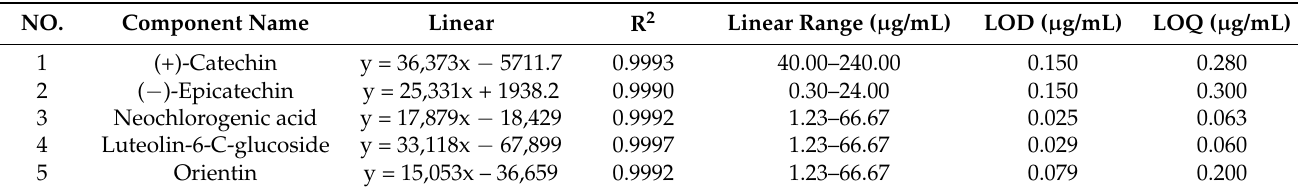
(Table 6). Qualitative and quantitative analyses of target chemical composition in the hairy roots and true roots were performed (Supplementary Materials Figure S4). The (+)-catechin and ( − )-epicatechin contents in the hairy roots were 692.63 ± 127.24 and 163.34 ± 31.86 µ g/g DW, respectively, whereas those in the true roots were 622.52 ± 97.53 and 70.21 ± 25.12 µ g/g DW, respectively (Table 6). The neochlorogenic acid, luteolin-6-C-glucoside, and ori- entin contents in the hairy roots were 45.95 ± 3.46, 209.68 ± 6.03, and 56.82 ± 4.75 µ g/g DW, respectively, which were higher than those in the tuber roots. The neochlorogenic acid, luteolin-6-C-glucoside, and orientin contents in the true roots were15.23 ± 0.38, 185.29 ± 1.19, and 44.06 ± 0.79 µ g/g DW, respectively. This showed that the accumulation of metabolites in the hairy roots and true roots was changed. Table 5. Standard curves, LOD, and LOQ were established by HPLC.